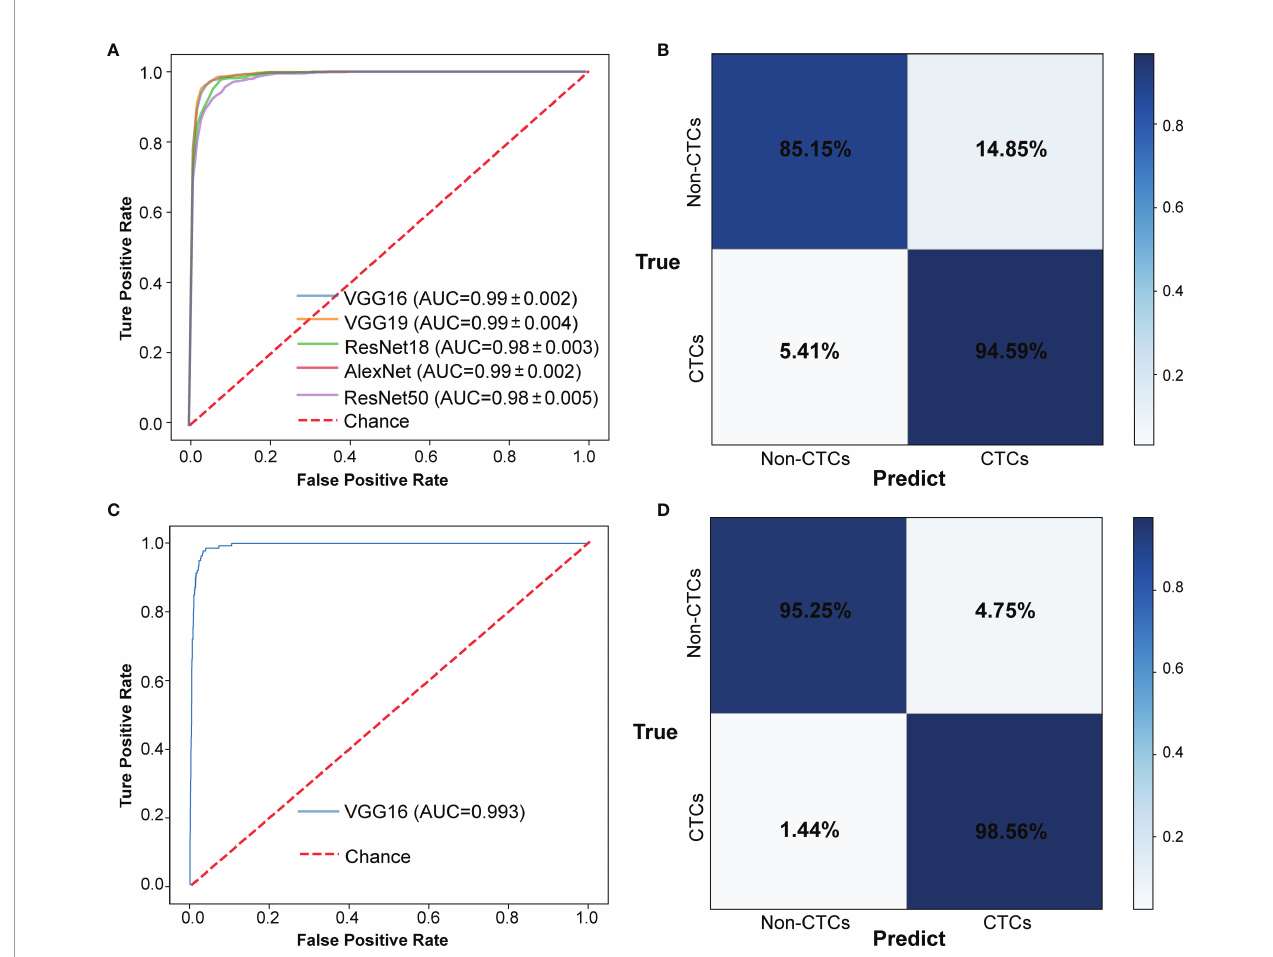
FIGURE 5 | The results of CTCs identify based on transfer learning. (A) ROC curve of 5-fold CV in train data set. (B) Confusion matrix of 5-fold CV in train data set. (C) ROC curve in test data set. (D) Confusion matrix in test data set.